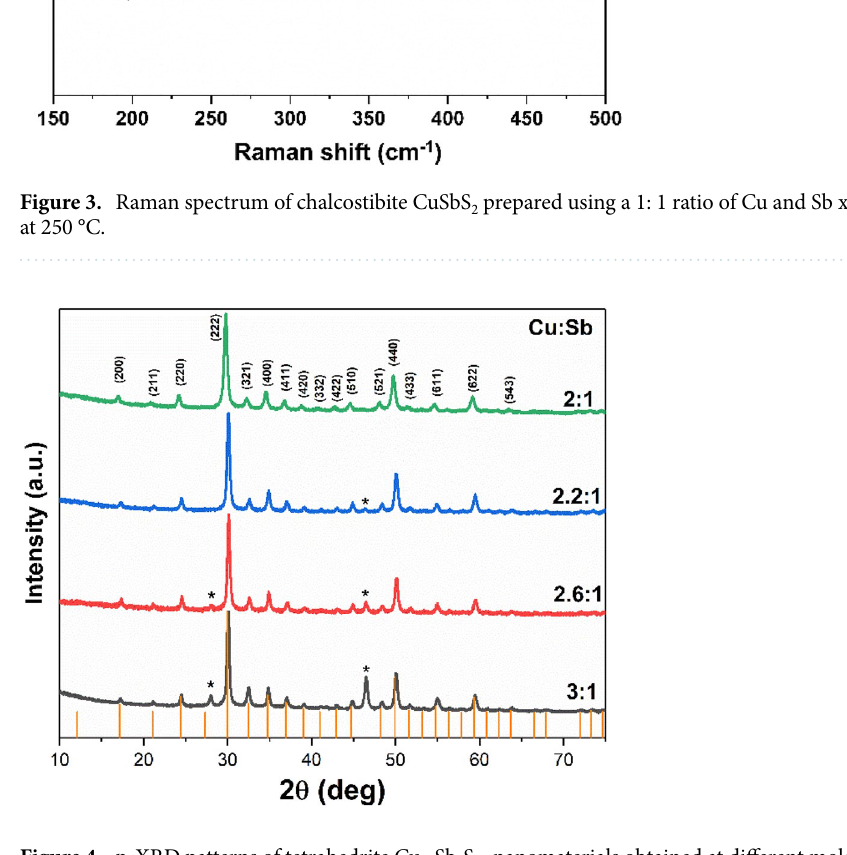
Figure 4. p-XRD patterns of tetrahedrite Cu 12 Sb 4 S 13 nanomaterials obtained at different molar ratios of copper and antimony xanthate precursors. Orange lines are from the standard reference pattern for cubic Cu 12 Sb 4 S 13 (tetrahedrite, ICDD: 01-088-0283). * Indicates the impurity peaks associated with formation of Cu 2−x S (ICDD: